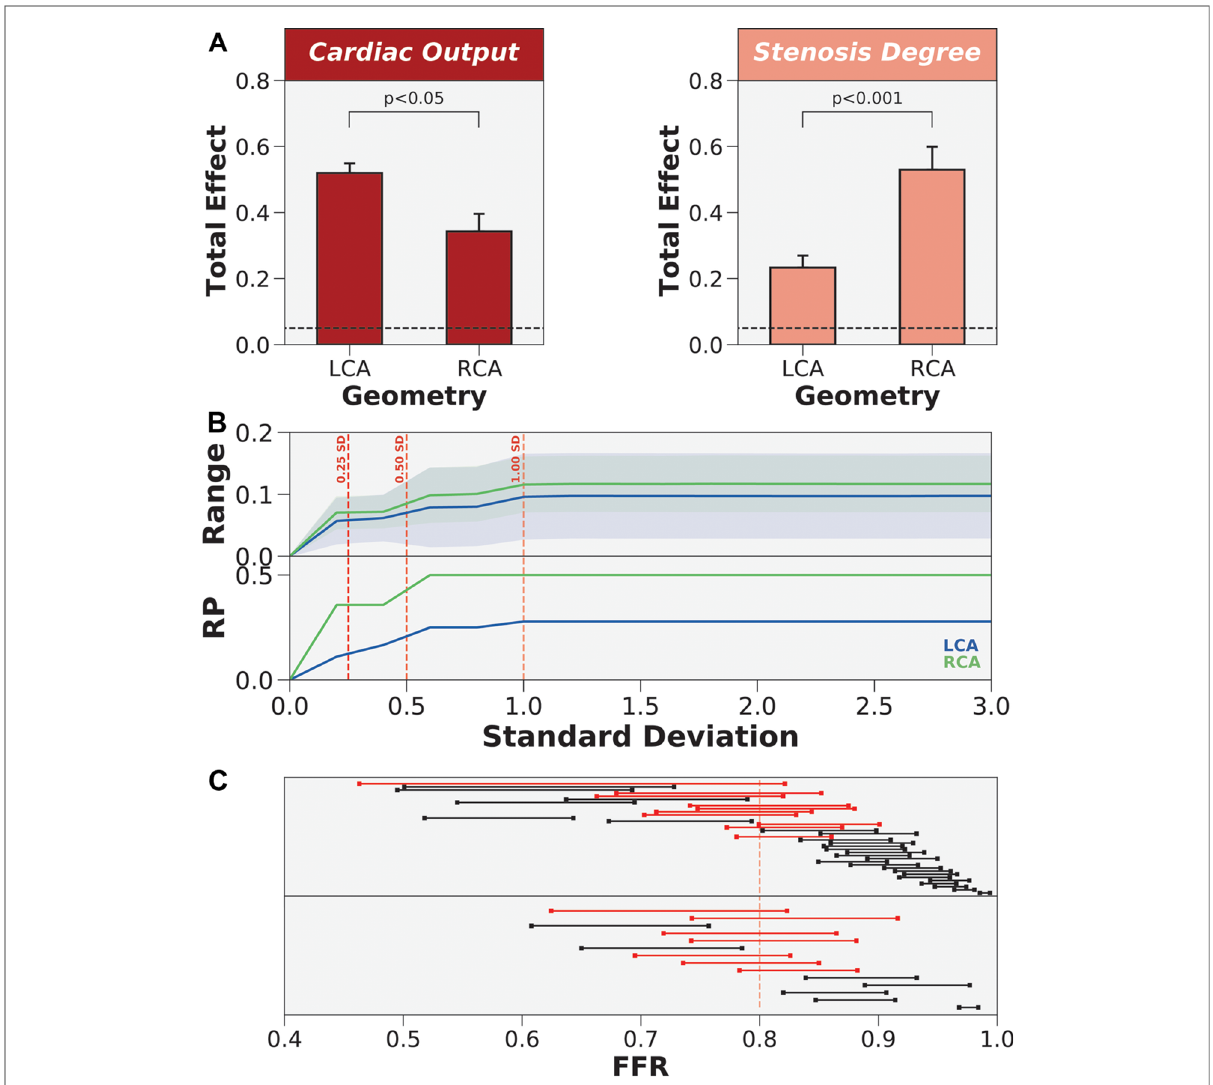
FIGURE 7 The differing impact of patient-speci fi city in cardiac output and stenosis degree between anatomies. ( A ) Coronary anatomy had differing effects on cardiac output and stenosis degree. LCA is left coronary artery and RCA is right coronary artery. ( B ) Re-sampling the global parameter space to estimate FFR range and reclassi fi cation proportion (RP) when only varying cardiac output and stenosis degree. Normal distributions of uncertainty were re-sampled at increasing levels of standard deviation (SD). ( C ) Dumbbell plot showing the range of FFR values when re-sampling to include 1 standard deviation of the variability in cardiac output and stenosis degree. Red dumbbells indicate re-classi fi ed cases and black dumbbells indicate cases without re-classi fi